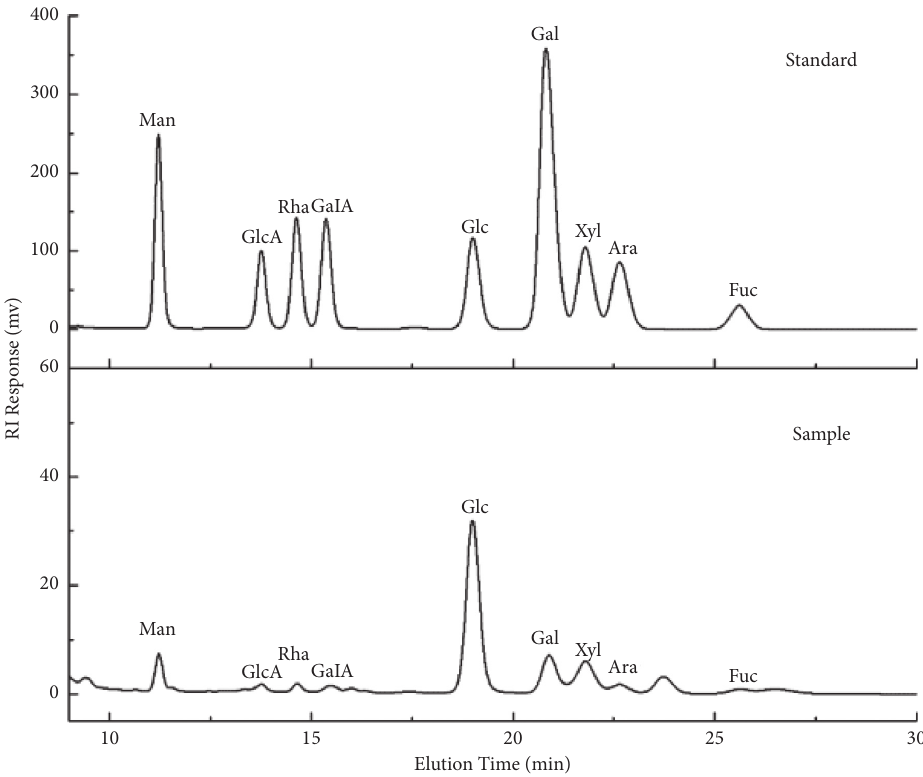
Figure 4: Composition of IOP-2A monosaccharide and liquid phase curve of the standard.